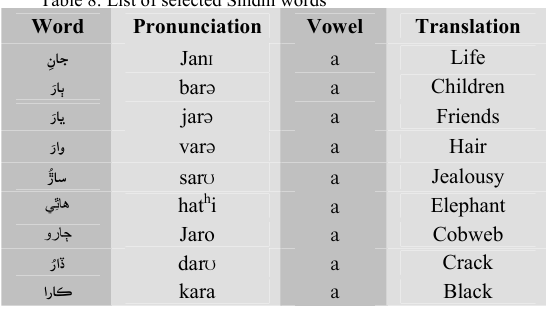
Table 6: Diphthongs of Sindhi as defined by IPA